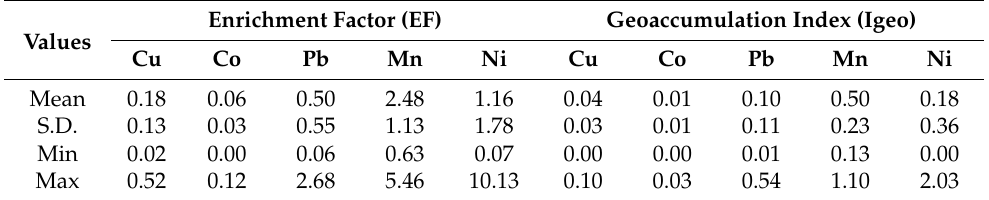
Table 3. The Enrichment factors (EF) and geoaccumulation indexes (Igeo) of surface sediments.